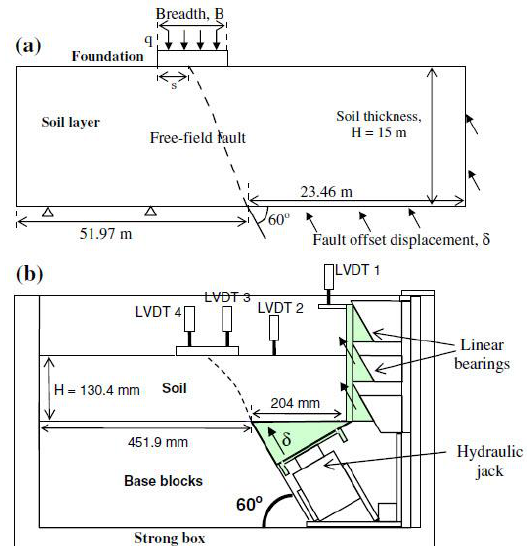
Fig 6. Schematic of real and experimental model [23].